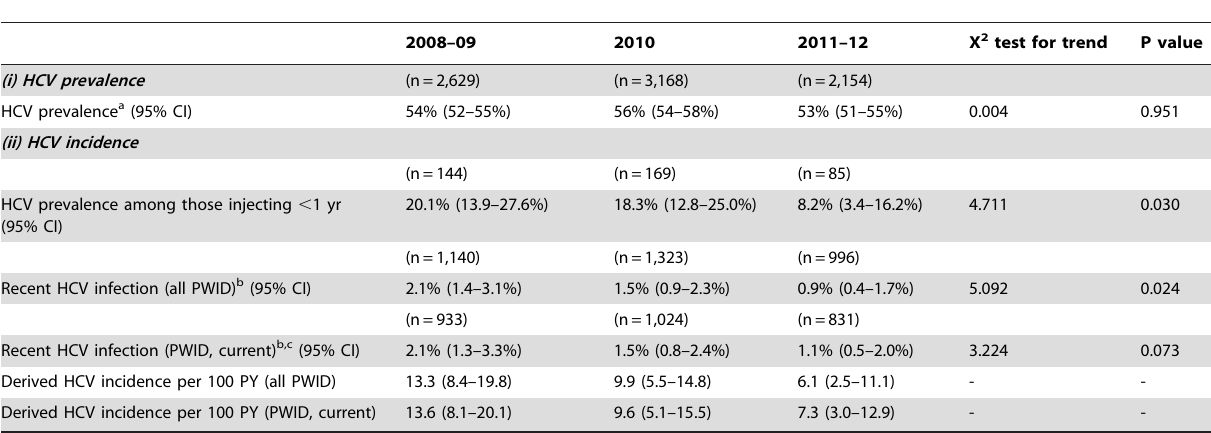
Table 4. Group-level analyses: HCV prevalence and incidence, by